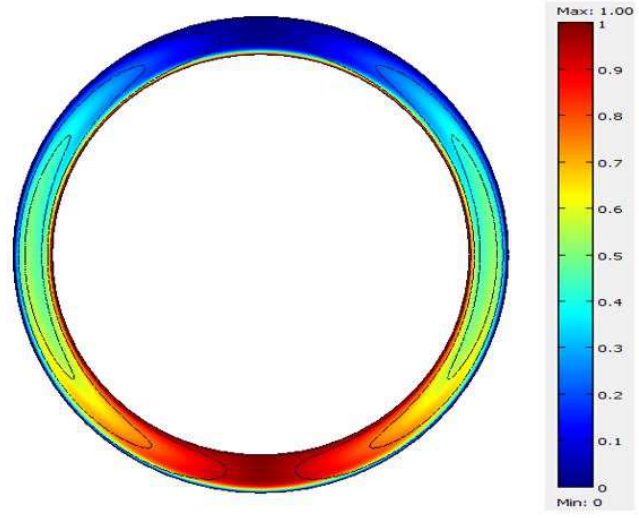
Figure 6. Variation in the mass fraction for Ra = 50, Le = 100, Ψ = 0.2 and R = 2 1/4 blue (red) corresponds to low (high) mass fraction values.